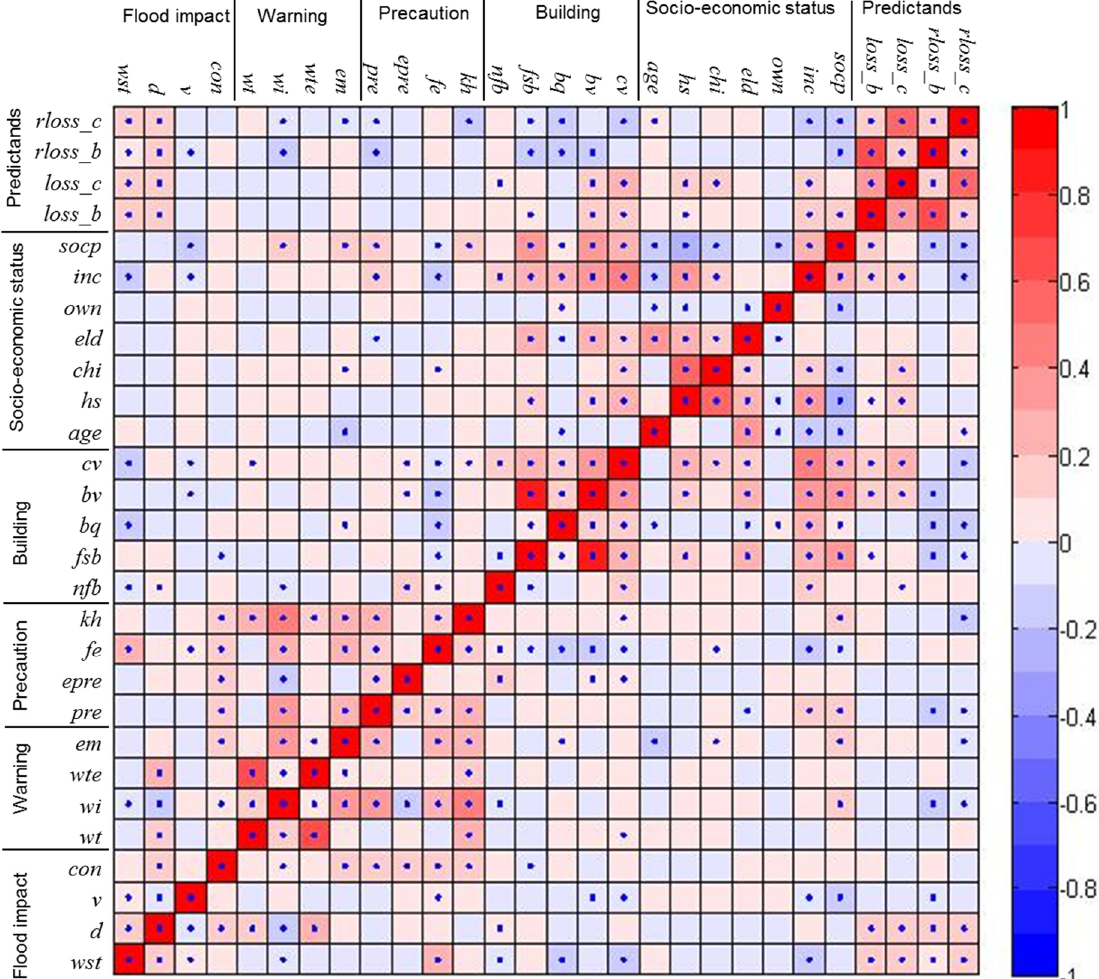
Figure 2. The Pearson correlation of 23 candidate predictors and four predictands for: absolute loss for buildings (loss_b); absolute loss for content (loss_c); loss ratio for buildings (rloss_b); loss ratio for content (rloss_c). The upper row contains the correlation between the candidate predictors and predictand. The red color indicates positive correlation, and the blue one indicates negative correlation. Significant correlation ( p < 0.05) is marked by a dot.